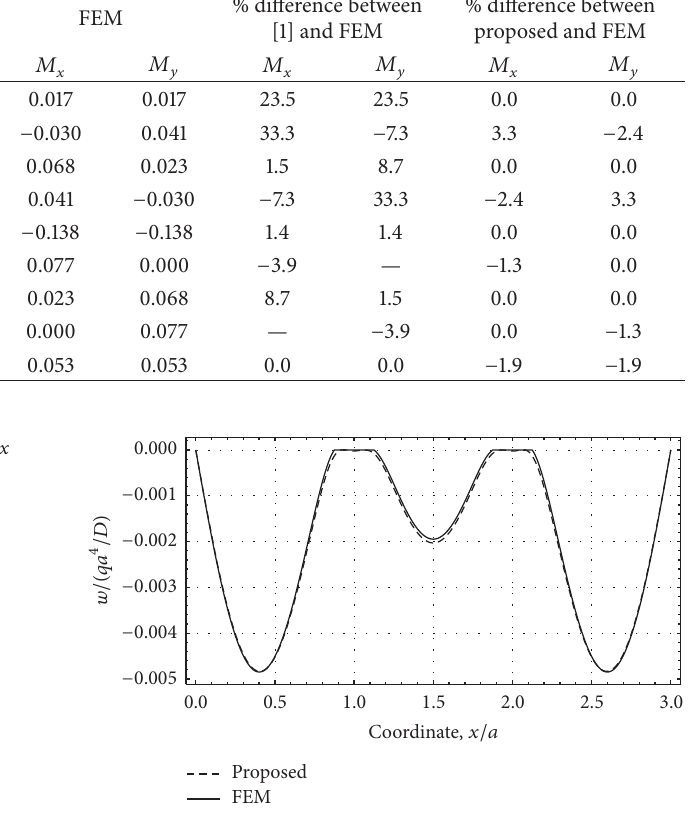
Figure 8: Deflection, 𝑤 , along the line at 𝑦 = 𝑎 .